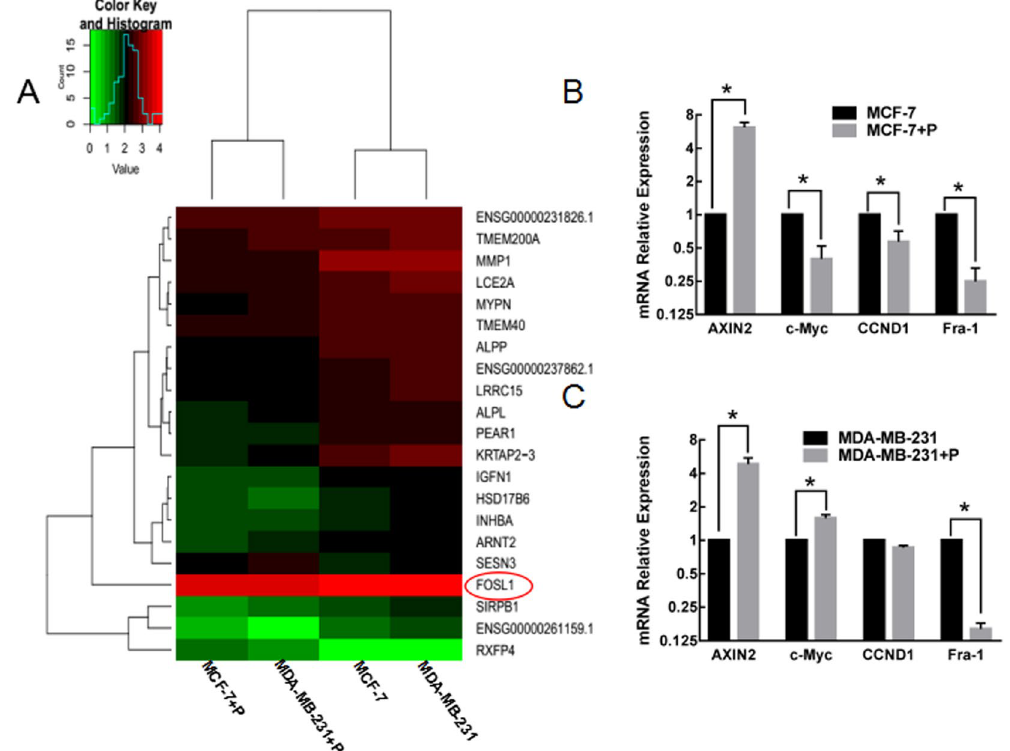
Figure 2. Effects of psoralen on the Wnt/ β -catenin signaling target genes. ( A ) Heatmap of differentially expressed genes (DEGs) in psoralen-treated samples and control samples. ( B , C ) Quantitative RT-PCR of Wnt/ β -catenin target genes Fra-1, cyclin D1, c-Myc and Axin2 showed the expression levels in psoralen-treated MDA-MB-231 cells and psoralen-treated MCF-7 cells as well as their control cells ( * p <